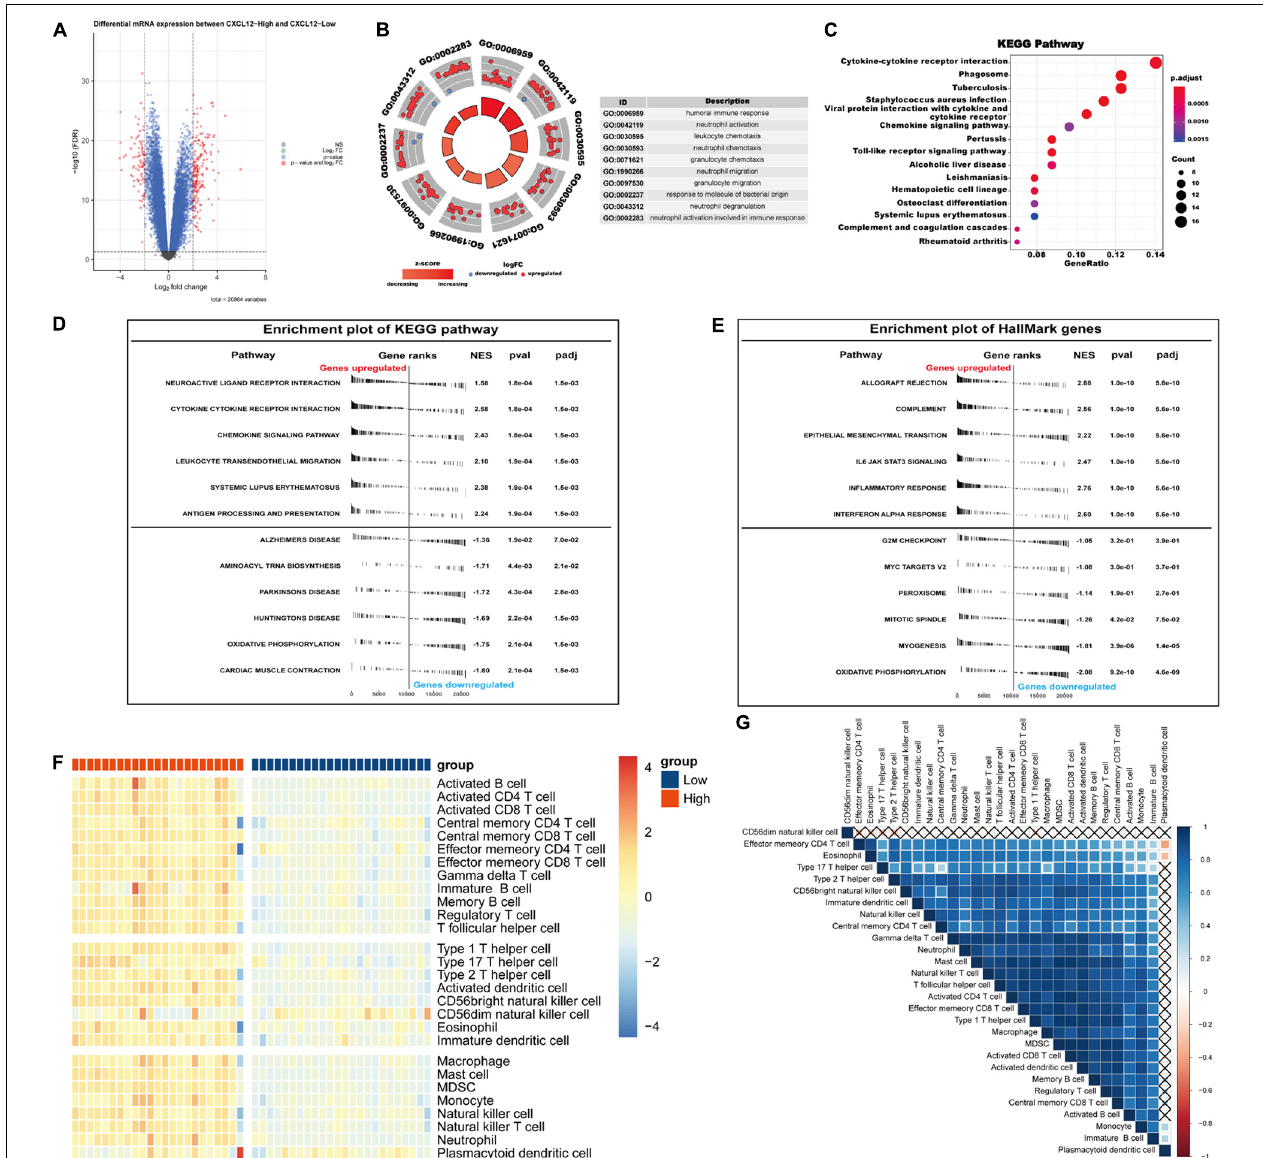
FIGURE 7 | Gene Ontology/KEGG pathway enrichment of CXCL12-high and CXCL12-low group, GSEA and ssGSEA analysis of AF. (A) Volcano plot of DEGs between CXCL12-high and CXCL12-low group. (B) The top 10 enriched GO annotation terms. (C) The top 15 enriched KEGG pathway. (D,E) GSEA results in the context of gene sets for canonical pathways gene sets derived from the KEGG pathway database (D) and gene sets that contain genes annotated by the HallMark ontology term (E) . (F) Analyzing the types of immune cell infiltration in the CXCL12-high and CXCL12-low groups by ssGSEA. The color scale from blue to red indicates downregulation to upregulation. (G) Correlation heatmap among different immune cells. GSEA, Gene Set Enrichment Analysis; ssGSEA, single-sample Gene Set Enrichment Analysis.